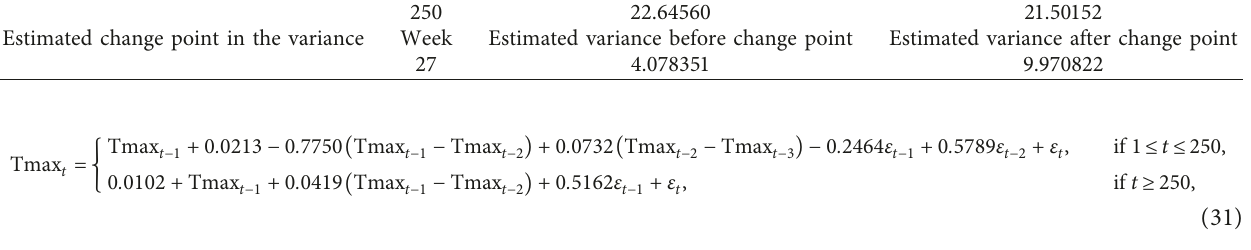
Table 4: Single change point location for the mean and the variance for maximum temperature using the library changepoint of R . Estimated change point in the mean Week Estimated mean before change point Estimated mean after change point 250 22.64560 21.50152 Estimated change point in the variance Week Estimated variance before change point Estimated variance after change